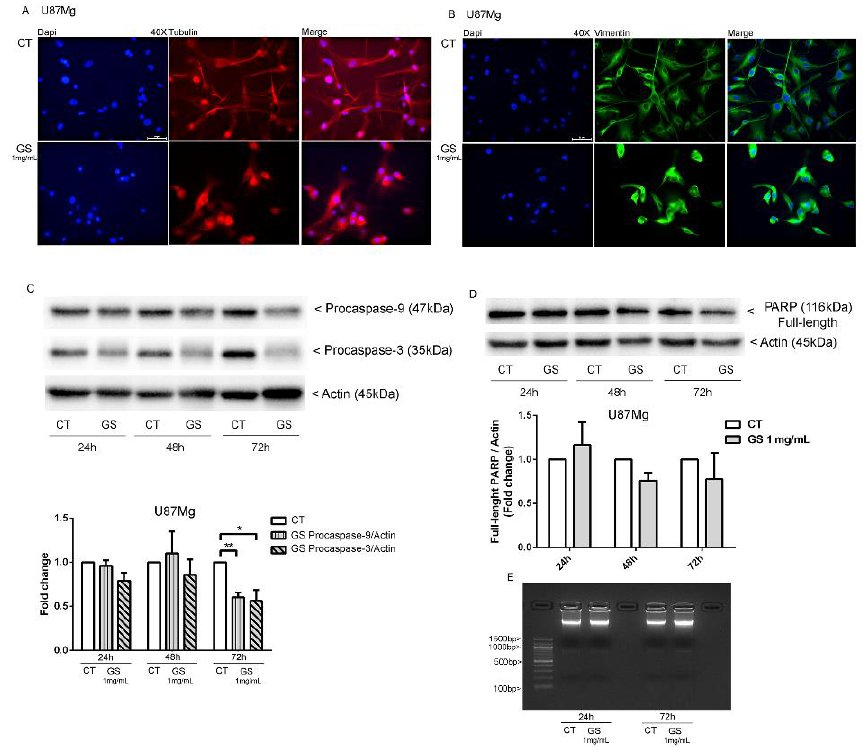
Figure 3. Reorganisation of cytoskeletal proteins in 1 mg/mL GS-treated cells. DMSO 0.3% was used as vehicle control. Immunofluorescence for α -tubulin ( A ) and vimentin ( B ). ( C ) Western blot analysis of apoptotic-associated proteins Procaspase 9, Procaspase 3, and ( D ) PARP in U87Mg cells treated with GS 1 mg/mL and DMSO 0.3% as vehicle control. Densitometric analysis of protein levels represent the means ± SEM of 3 individual determinations. Data were normalised to housekeeping gene Actin and are expressed as fold change over control-treated cells. * Unpaired t -test. According to GraphPad Prism, * p -value 0.01 to 0.05 (significant), ** p -value 0.001 to 0.01 (very significant). ( E ) Agarose gel for DNA ladder at 24 and 72 h from treatment of U87Mg with GS 1 mg/mL. DMSO 0.3% was used as vehicle control. There is no evidence of DNA fragmentation.